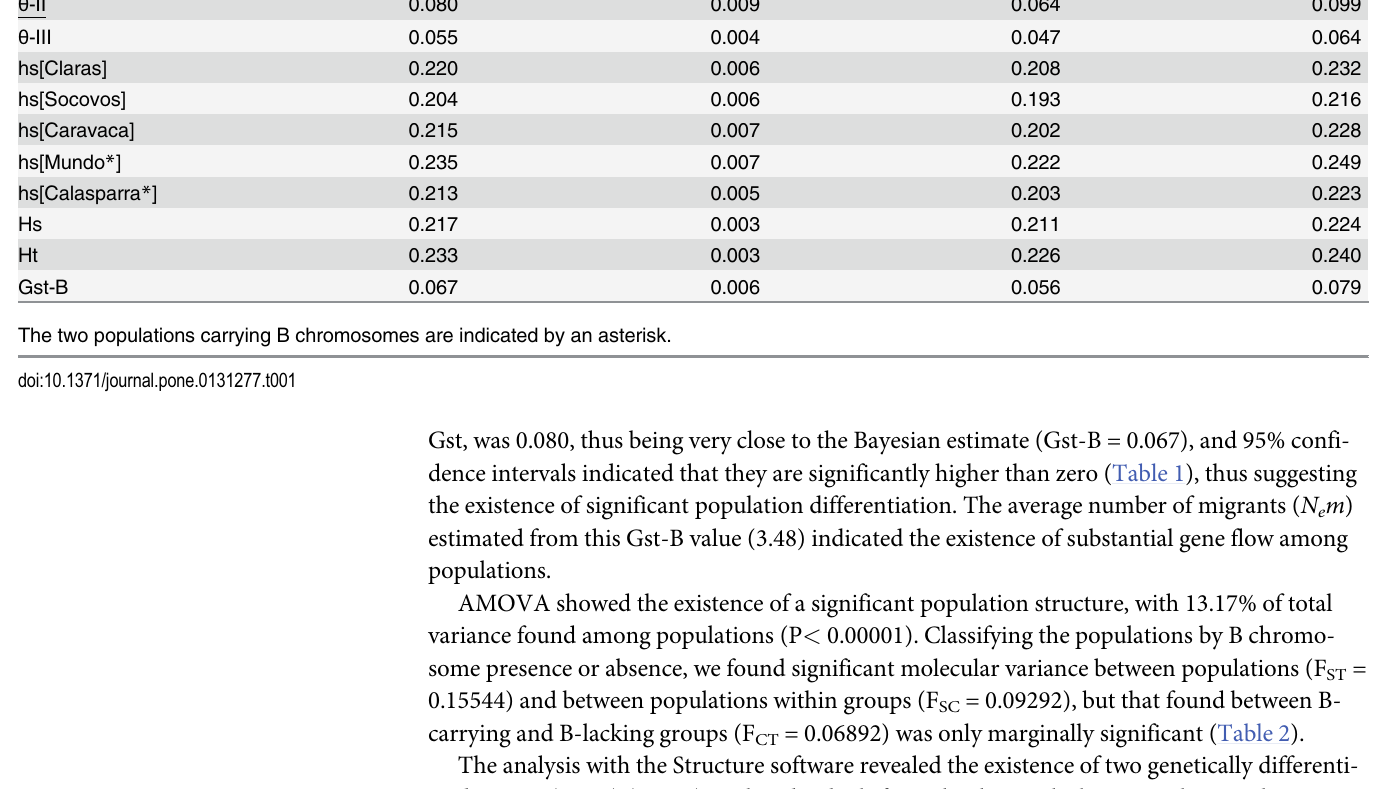
Table 2. AMOVA for ISSR markers in five populations of the grasshopper E . plorans collected in the Segura River Basin. Source of variation